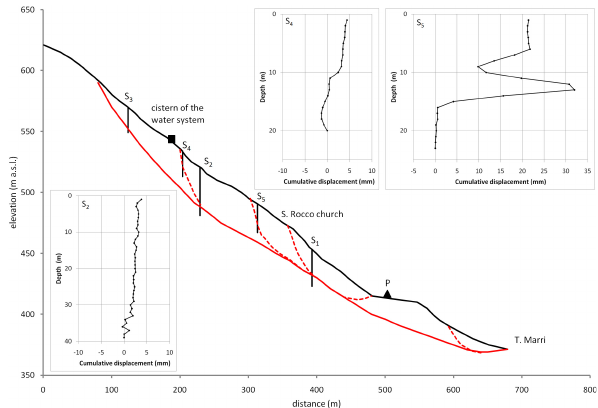
Fig. 6. San Rocco landslide: schematic section of the slope show- ing the different bodies considered for the limit equilibrium back- analyses. Location and depth of the boreholes, together with the main surfaces of rupture and the results of inclinometric measures (updated at December 2009) at boreholes S 2 , S 4 and S 5 are also shown.